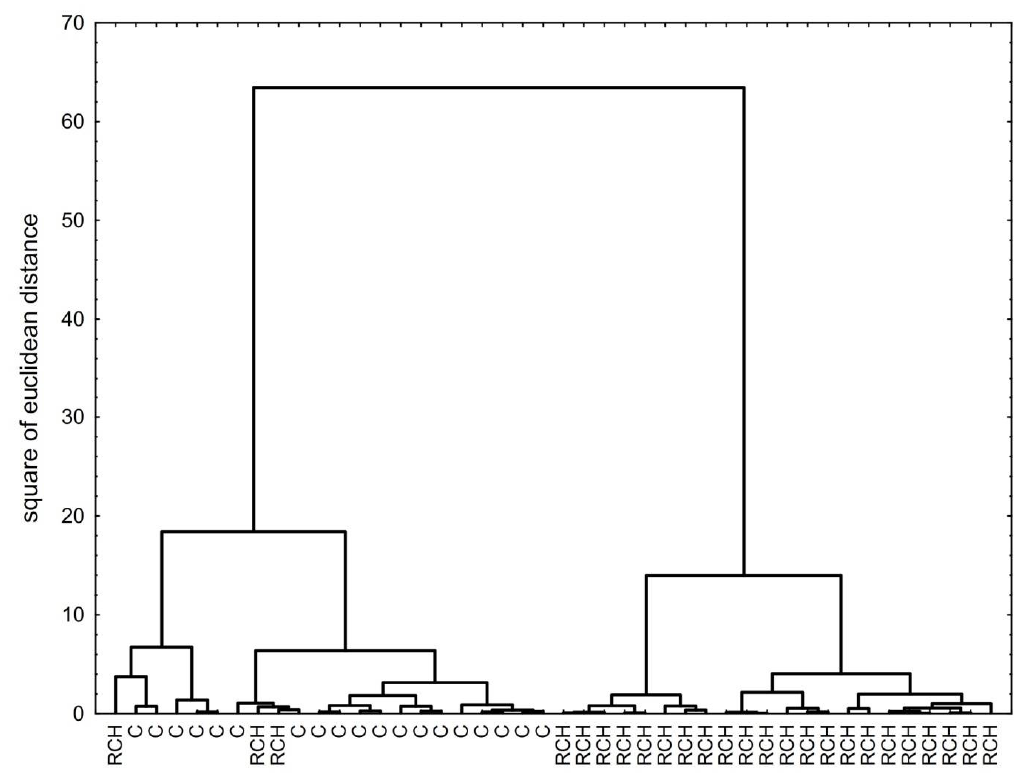
Figure 5. Cluster analysis grouping the soil from the charcoal hearth horizon (RCH) and control soil (C); chemical properties